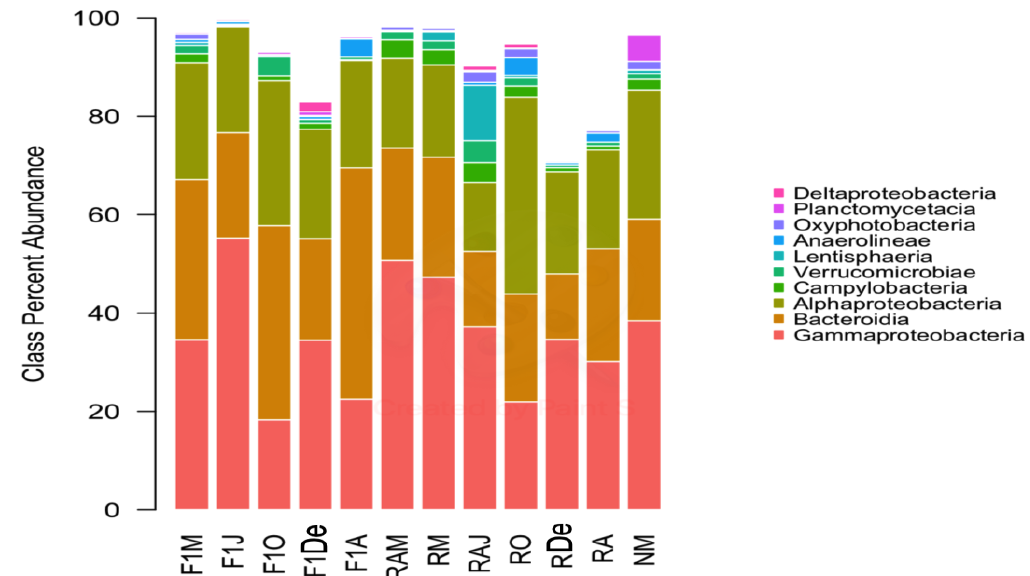
Figure 2. Composition of samples based on the ten most abundant bacterial classes. Colors correspond to the taxa given in the legend. F1M, F1J, F1O, F1De, and F1A: first-generation juvenile specimens born in the center (F1) sampled in March, June, October and December 2014, and April 2015, respectively. RM, RO, RDe, and RA: younger reproductive adults sampled in March, October, and December 2014 and April 2015, respectively. RAM, RAJ: older reproductive adults sampled in March and June 2014, respectively. NM: Nursery larvae sampled in March 2014.